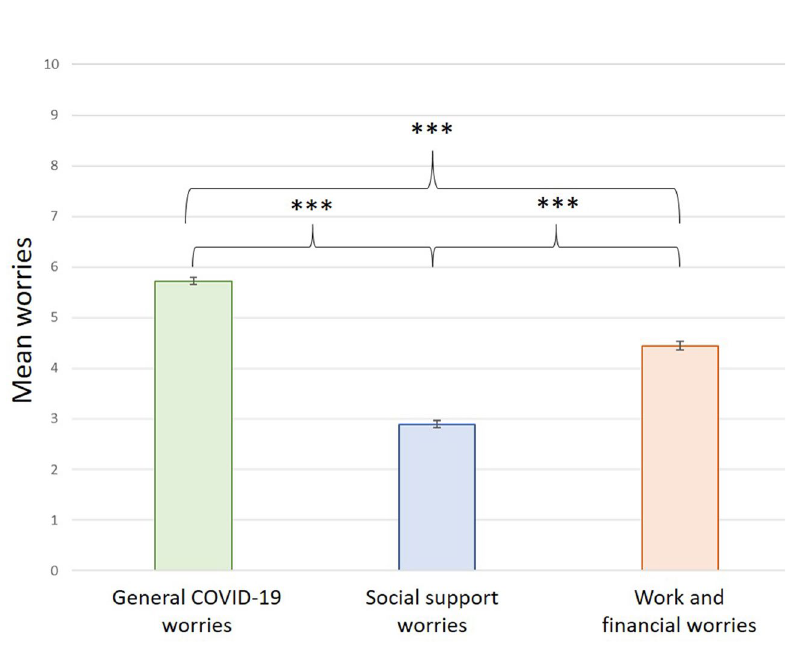
Figure 1. Bar charts depicting the means and standard errors of the COVID-19-related stress: General COVID-19 worries (green), social support worries (blue) and work and financial worries (orange). ***p <